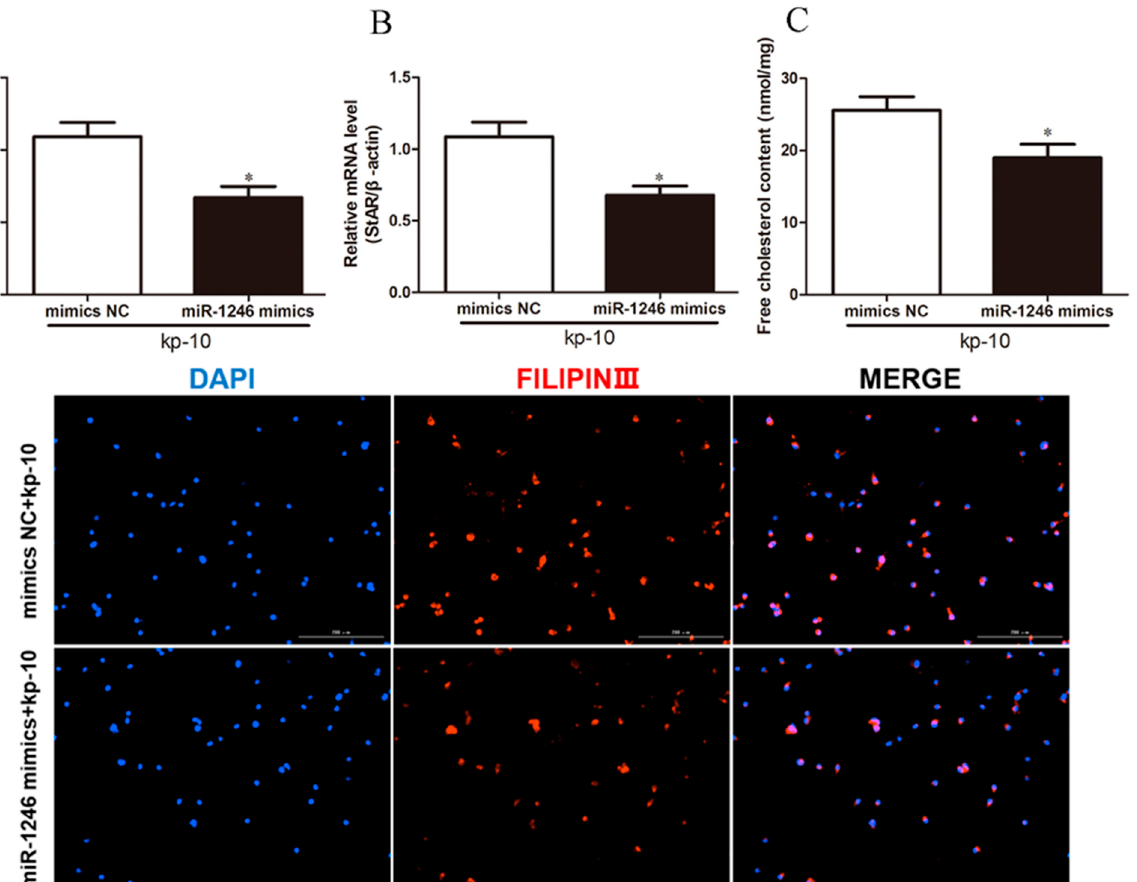
Figure 3. Underexpression of miR-1246 promotes P4 synthesis in BGCs. ( A ) The level of P4 in BGCs. ( B, C ) Relative mRNA expression of StAR and miR-1246 in BGCs. ( D ) Representative filipin staining of BGCs. ( E ) Relative content of free choles- terol in BGCs. Inhibitor NC, negative control of miR-1246 inhibitor; miR-1246 inhibitor, underexpression of miR-1246. All data were presented as the mean ± SD ( n = 3), * p < 0.05.